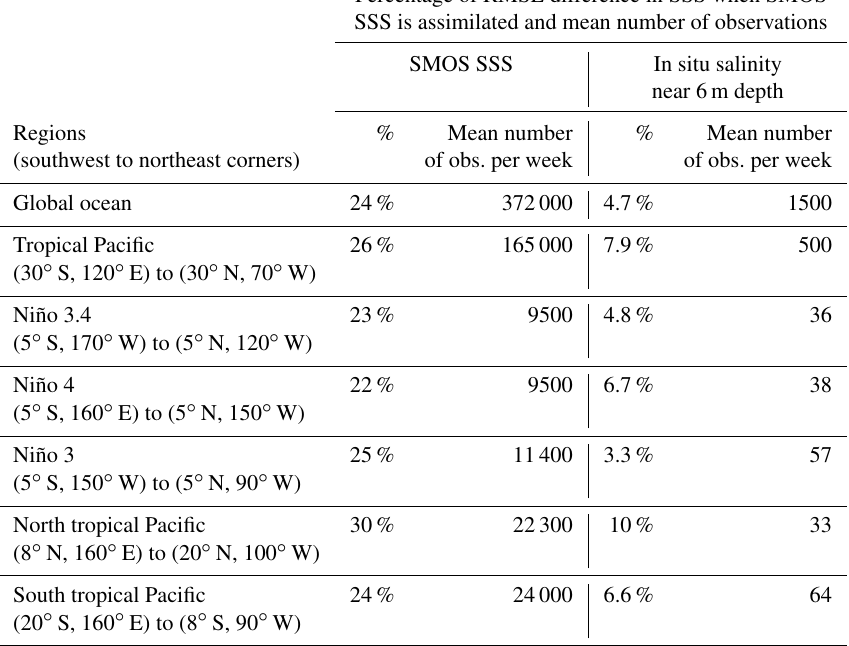
Table 3. Percentage of RMSE difference in SSS for SMOS and for in situ salinity at 6m depth in different regions. The average number of SSS data assimilated per week is also indicated. Percentage of RMSE difference in SSS when SMOS SSS is assimilated and mean number of observations SMOS SSS In situ salinity near 6m depth Regions % Mean number % Mean number (southwest to northeast corners) of obs. per week of obs. per